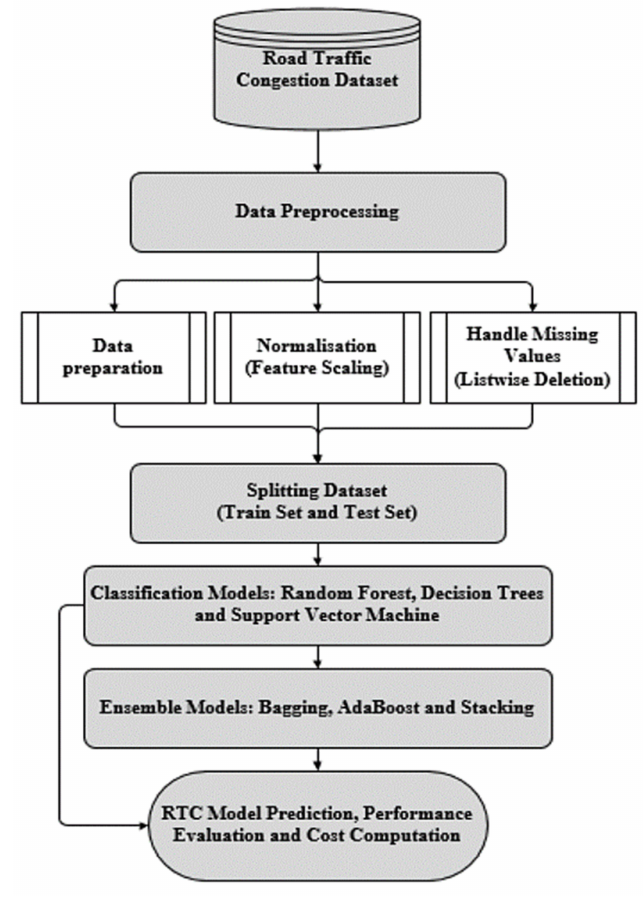
Figure 1. Road traffic congestion experimental process. Table 2. Experimental methods for the